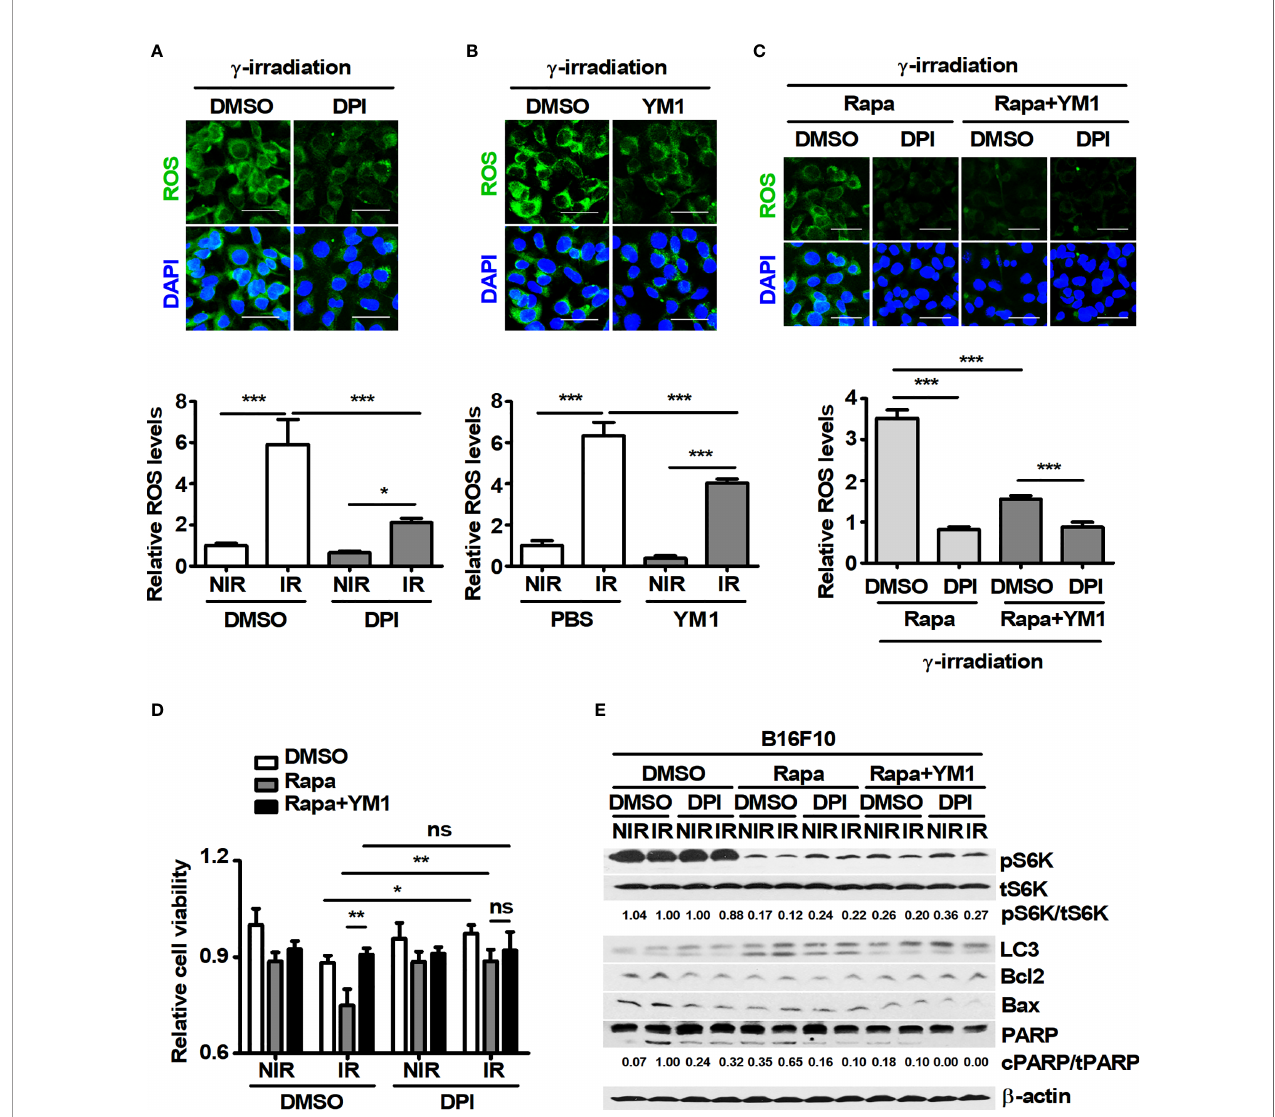
FIGURE 5 | YM1 affects ROS-induced cell death in B16F10 cells under g -radiation. (A – E) After pretreatment with diphenyleneiodonium (DPI) for 1 h, B16F10 cells were treated with DMSO or 100 nM rapamycin for 3 h. B16F10 cells were washed with PBS and then incubated with DMEM and rapamycin in the presence or absence of 125 ng/ml rmYM-1 for 3 h before receiving 3-Gy g -irradiation. After g -irradiation, B16F10 cells were incubated with 5 m M CellROX for 30 min. (A – C) Intracellular ROS were assessed by confocal microscopy. Scale bars, 50 m m. (D) Cell viability was measured by an automated cell counter. (E) The protein levels of p70 S6K, phospho-p70 S6K, LC3, Bcl2, Bax, and PARP in B16F10 cells were evaluated by western blotting. b -actin was used as an internal control. The bars and error bars represent the mean ± SD; * P < 0.05; ** P < 0.01; *** P < 0.001; ns, not signi fi